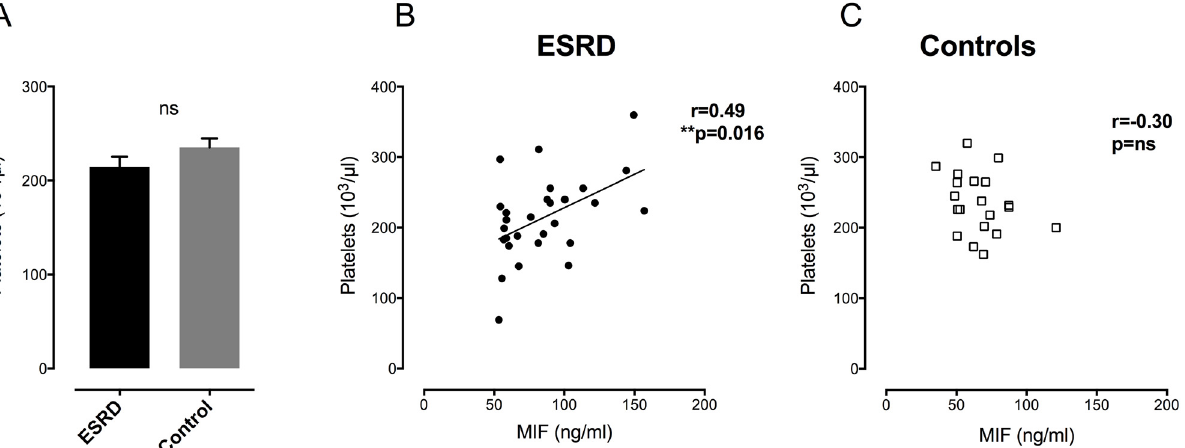
Fig 3. Hemodialysis removes large amounts of MIF from the circulating MIF plasma pool. Illustration of the experiment shows the estimated amount of circulating MIF levels in our patient cohort. Plasma levels were calculated being 5% of body weight (4.3L). Multiplication with the measured average MIF plasma level revealed an amount of 370 μ g/patient. An average amount of 219 ± 39 μ g MIF was removed in a single HD session.